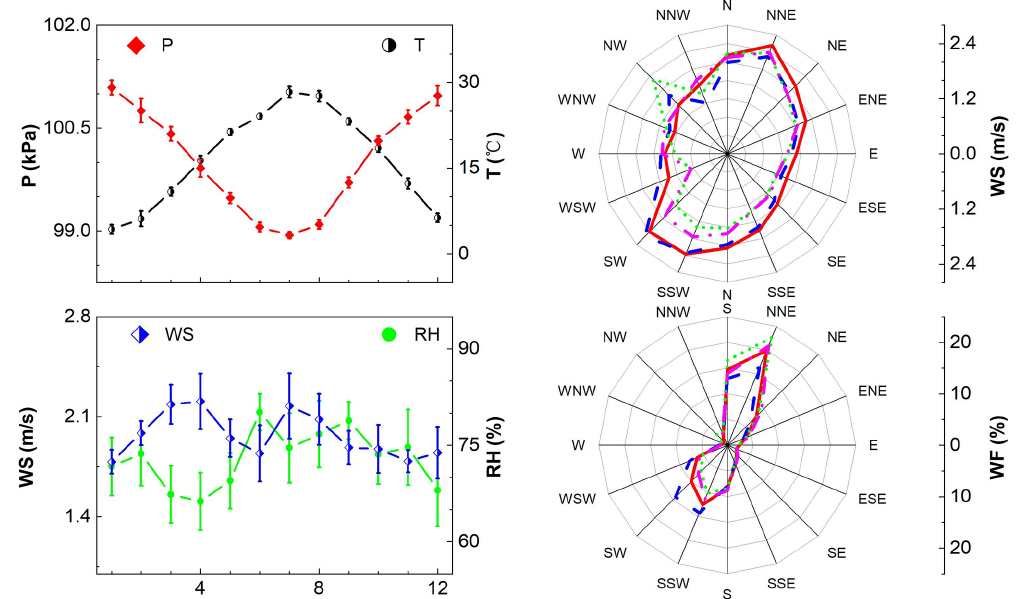
Figure 2. Average seasonal variations in air pressure ( P ), temperature ( T ), wind speed (WS), relative humidity (RH), and rose maps of wind speed (WS) and wind direction frequency (WF) at LAN during 2006–2016. In the rose maps of WS and WF, solid red represents spring, dashed blue for summer, green dots for autumn and dot-dashed magenta for